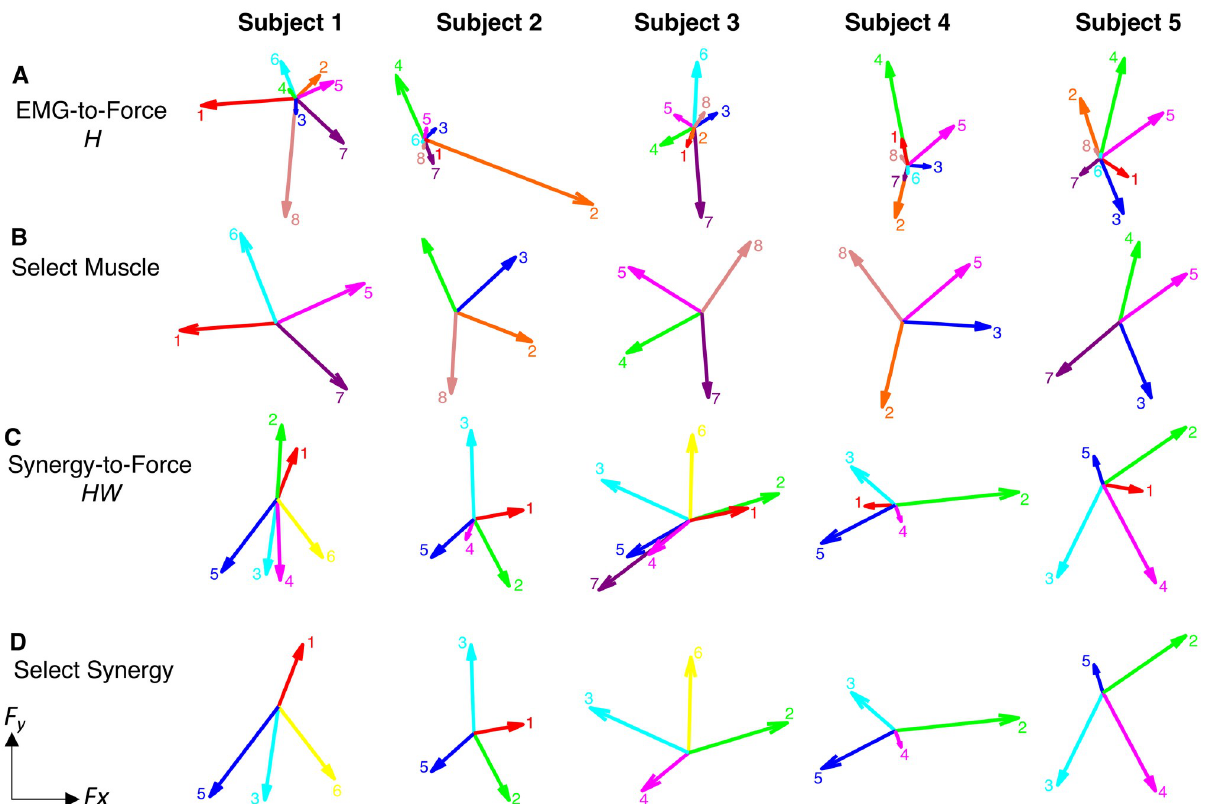
Fig 2. EMG-to-force mapping and synergies. Row A) EMG-to-force matrix H estimated for each participant from EMG and force data recorded during the force-control block. Each arrow represents the planar force generated by one muscle (1: pectoralis major (PEC), 2: brachioradialis (BRACH), 3: biceps (BIC), 4: triceps (TRIC), 5: anterior deltoid (AD), 6: lateral deltoid (LD), 7: posterior deltoid (PD), 8: middle trapezius (TRAP); Row B) The reduced mapping for the Select Muscle condition in the 2-D myocontrol task for each participant, using the four muscles with the highest TP that also spanned the 2-D space. Row C) Forces associated with the muscle synergies [shown on Fig 3]; Row D) The reduced mapping for the Select Synergy condition in the 2-D myocontrol task, using the four synergies with the highest TP that also spanned the 2-D space.